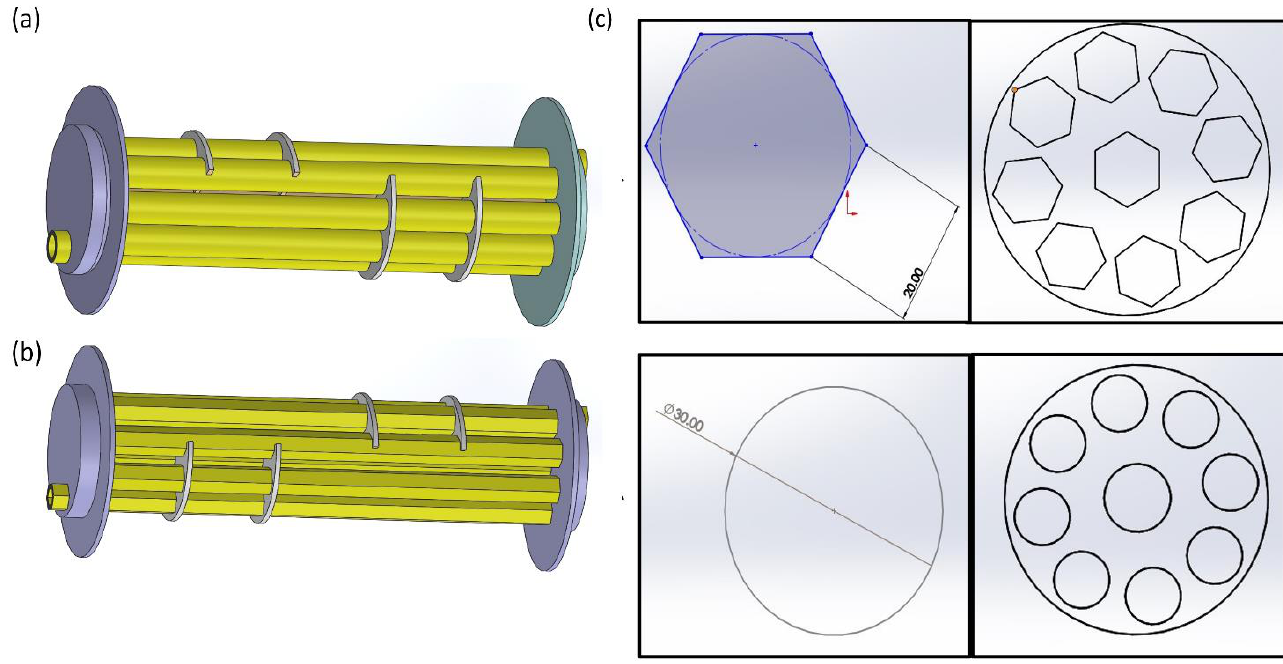
Figure 2. ( a ) Round tubes heat exchanger; ( b ) designed hexagonal tubes heat exchanger; ( c ) cross- sectional view of tubes for hexagonal and round